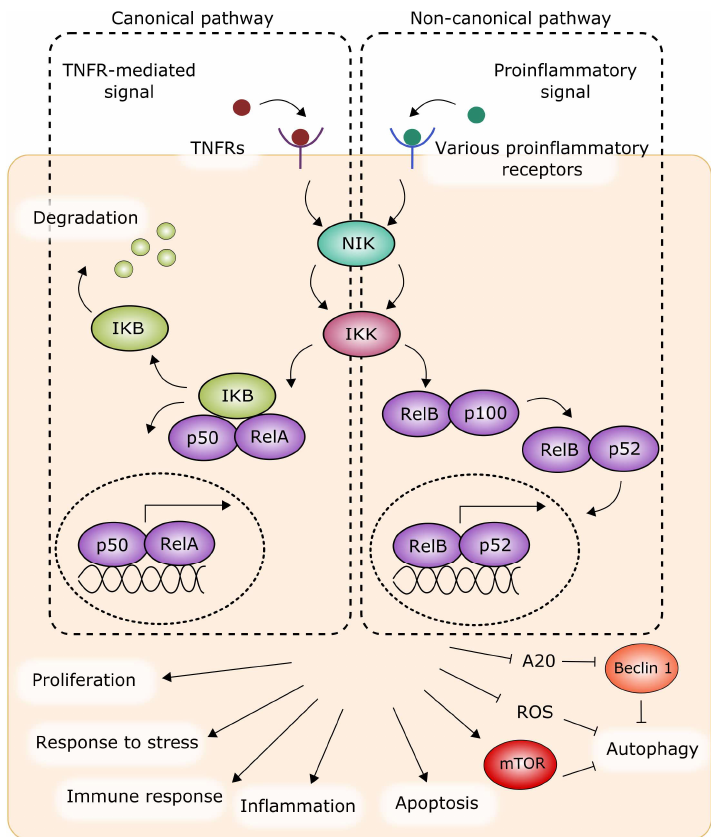
Figure 3. NF-κB (nuclear factor kappa-light-chain-enhancer of activated B cells) can be activated in a canonical (left) or non-canonical (right) pathway to stimulate or repress the expression of genes involved in the regulation of cellular response to stress, immune response, and inflammation. Either pathway is initiated by a ligand bound by its receptor. Some autophagy proteins can be related to both pathways, as discussed in Section 4. This figure is a simplified representation only and does not contain many important details. IKB (nuclear factor of kappa light polypeptide gene enhancer in B cells inhibitor); IKK: IκB kinase; mTOR: mammalian target of rapamycin; NIK: NF-κB-inducing kinase; TNFR: tumor necrosis factor receptor; ROS: reactive oxygen species. Subunits of NF-κB are shaded with the same, light fiolet color. Sharp arrows represent stimulation/induction, while blunt arrows: inhibition/downregulation, dashed oval: the nucleus.